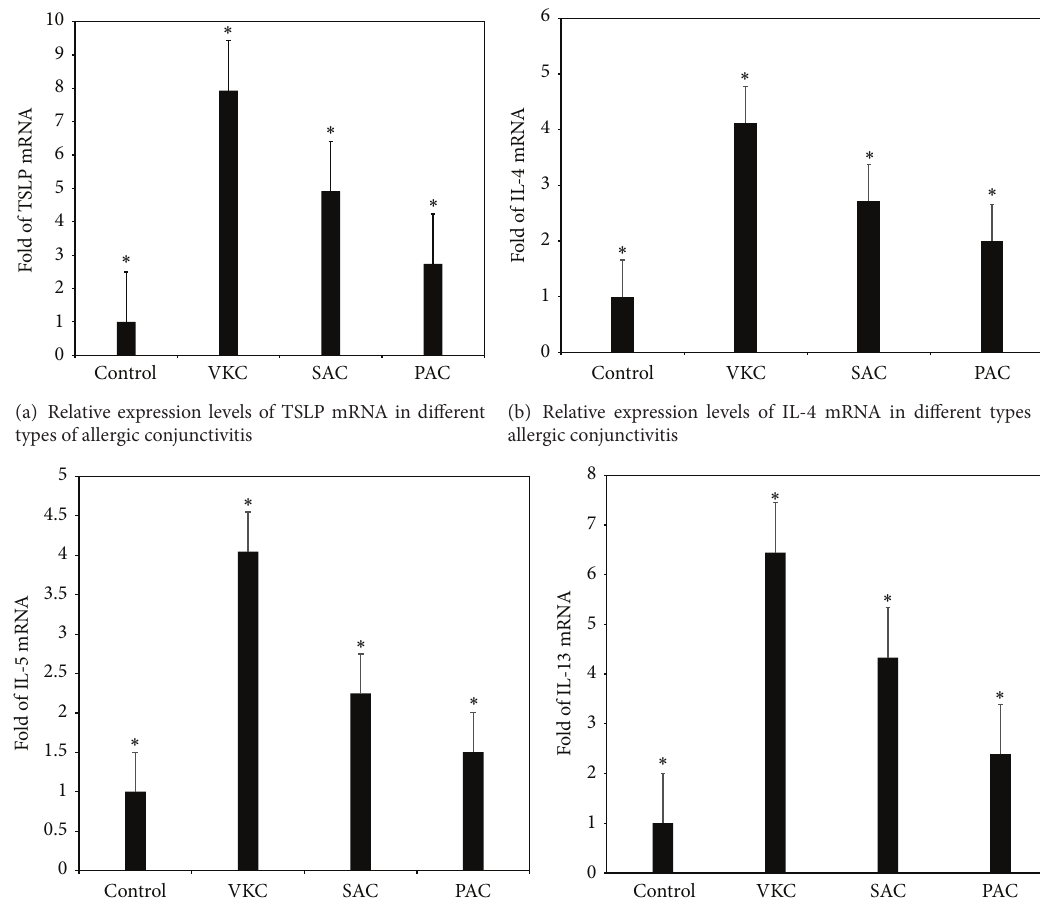
(c) Relative expression levels of IL-5 mRNA in different types of (d) Relative expression levels of IL-13 mRNA in different types allergic conjunctivitis of allergic conjunctivitis Figure 2: Relative expression levels of TSLP mRNA, IL-4 mRNA, IL-5 mRNA, and IL-13 mRNA in different types of allergic conjunctivitis. TSLP mRNA, IL-4 mRNA, IL-5 mRNA, and IL-13 mRNA expression levels are presented as relative fold in various types of allergic conjunctivitis over the normal controls, which were evaluated by RT and real-time PCR using gene expression assay, with GAPDH as an internal control. Results shown are the mean ± SD. ∗ 𝑃 < 0.05 ; each group 𝑛 = 20